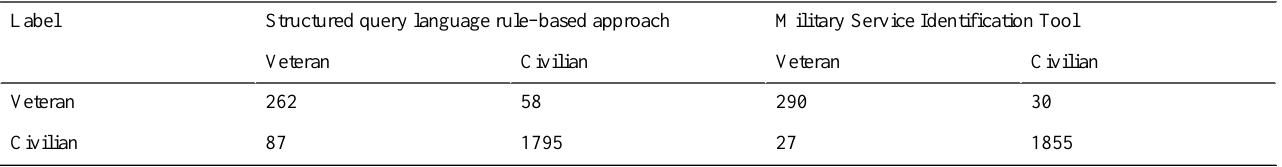
Table 5. Confusion matrix indicating the performance of the structured query language rule-based approach and the Military Service Identification Tool (MSIT). The MSIT includes pre- and